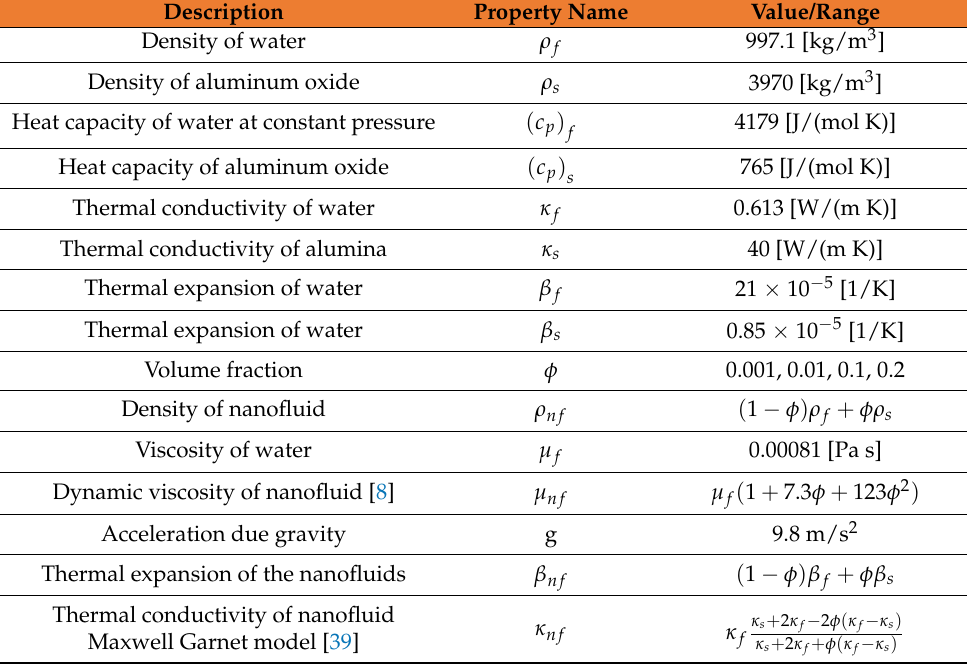
Table 1. Parameters and thermophysical properties